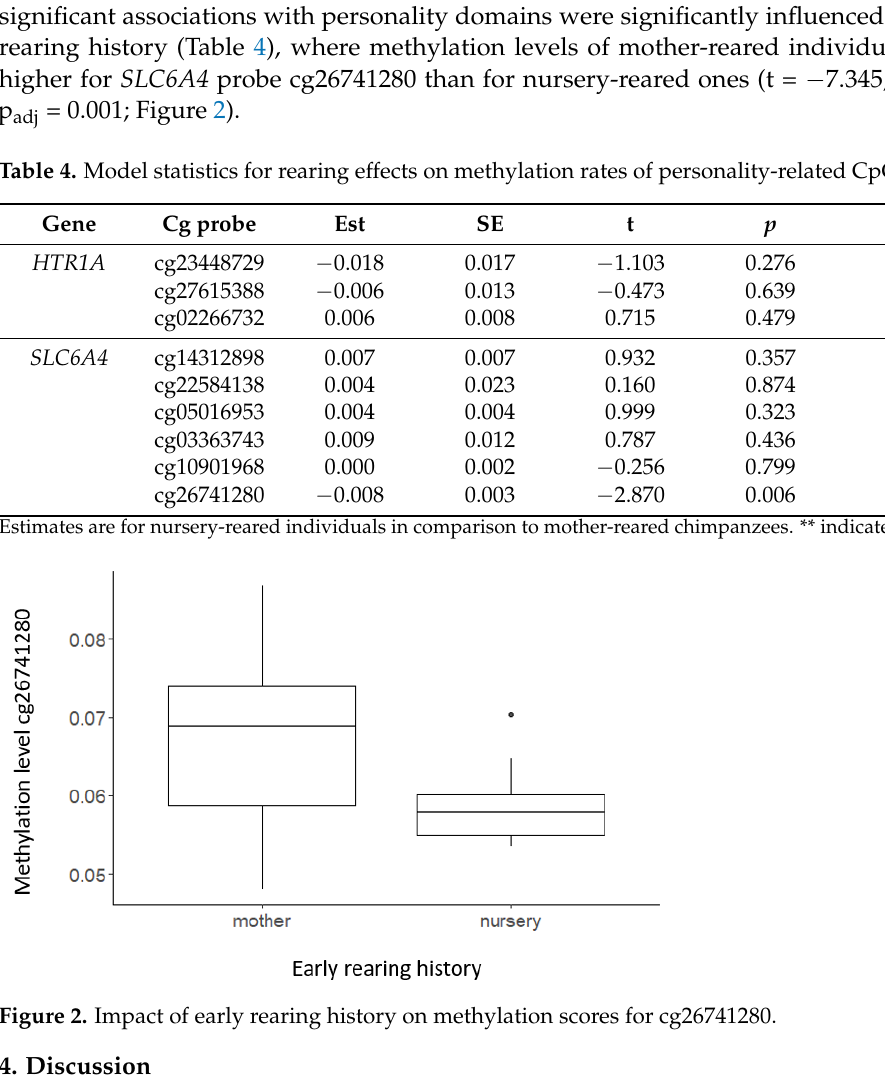
Table 4. Model statistics for rearing effects on methylation rates of personality-related CpG sites.